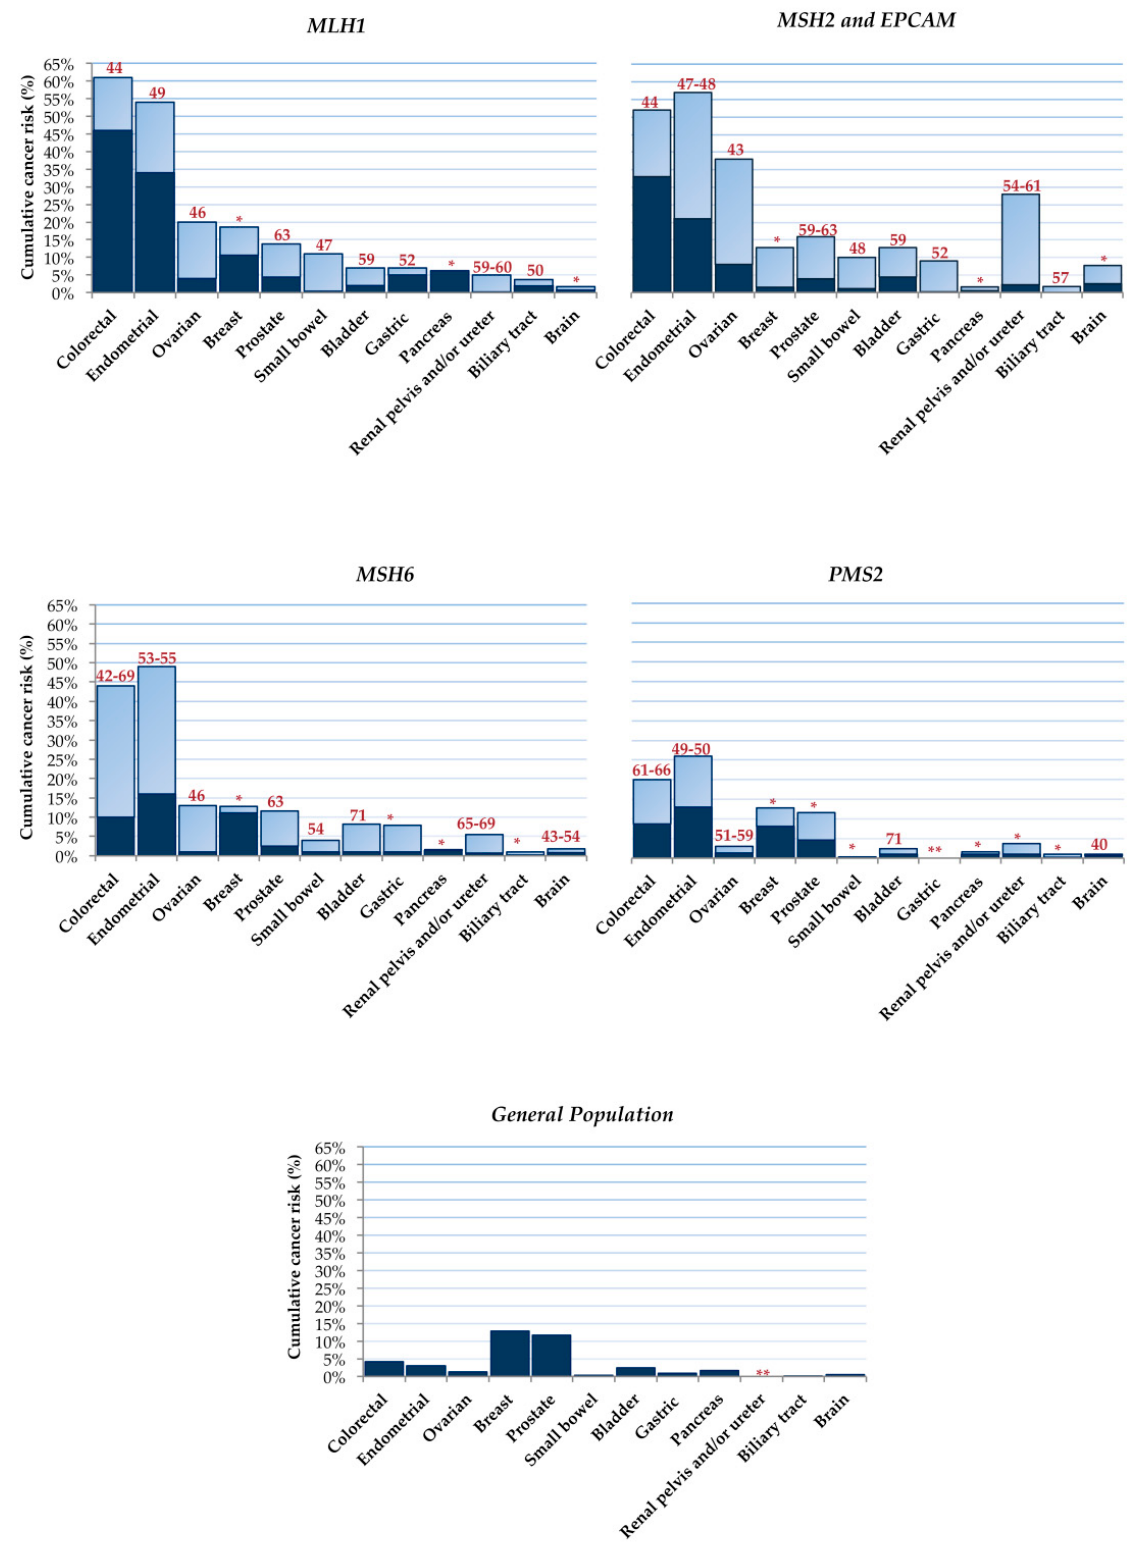
Figure 1. Cumulative risk of developing cancer in patients with LS according to the type of mismatch repair gene mutation by the age of 80. Dark and light blue bars indicate the lower and upper cumulative risk, respectively, for each cancer type. The red numbers above each bar represent the estimated mean age at presentation for each cancer type. Asterisks (*) and double asterisks (**) indicate that limited or no data are available for the mean age at presentation and the cumulative cancer risk,